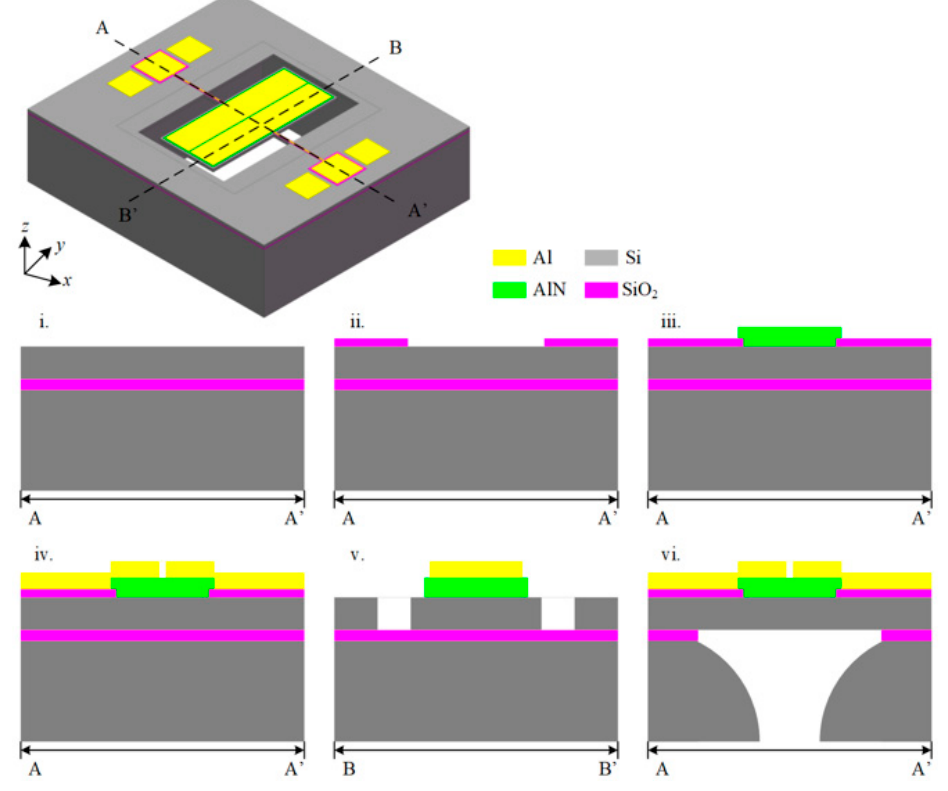
Figure 5. Process flow of thin-film piezoelectric-on-silicon (TPoS) resonator. ( i ) silicon on insulator (SOI) substrate top silicon doping; ( ii ) Thermal oxidation generates insulating layer; ( iii ) Generate piezoelectric film; ( iv ) Generate metal electrodes; ( v ) Top etch; (vi) Back etching. Step